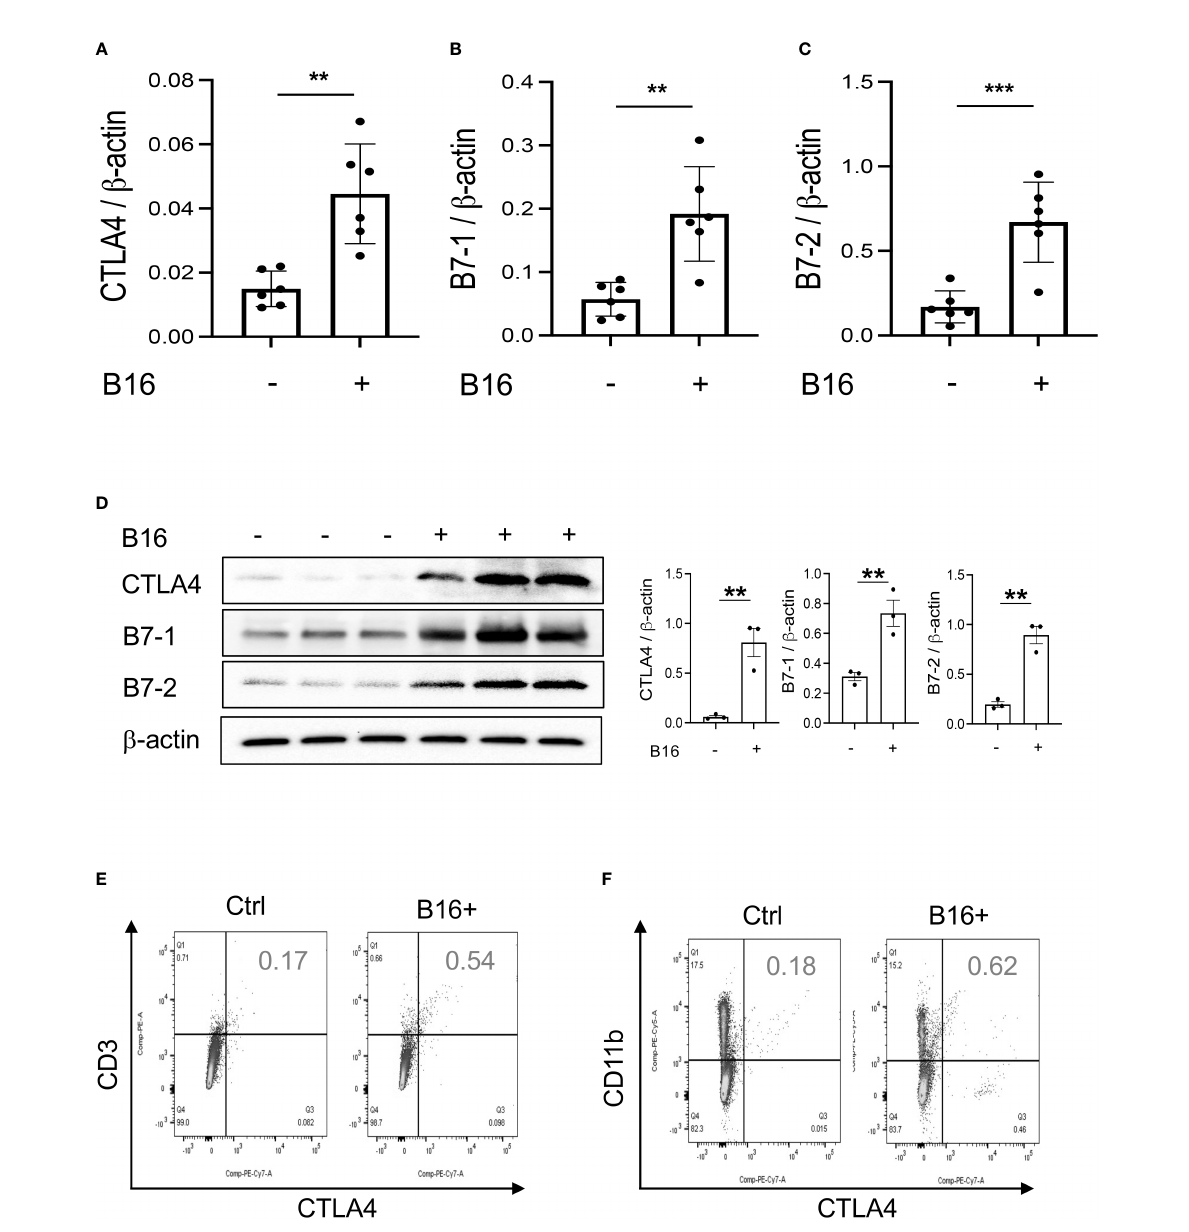
FIGURE 2 Chi3l1 plays a critical role in B16 melanoma stimulation of pulmonary CTLA-4 and its ligands. WT mice were given B16-F10 (B16) melanoma cells or control vehicle (PBS) and evaluated 2 weeks later. (A – C) RT-PCR was used to quantitate the levels of mRNA encoding CTLA-4, B7-1 and B72 in the lungs from mice treated intravenously with PBS vehicle (B16 -) or B16 cells (B16 +). Each dot represents an evaluation in an individual animal. (D) Western blot and densitometry evaluations of CTLA-4, B7-1 and B7-2 accumulation in lungs from WT mice treated with vehicle (B16-) or B16 cells (B16 +). (E, F) FACS analysis demonstrating the induction of CTLA-4 by CD11b+ and CD3+ cells. The plotted values in panels (A – C) represent the mean±SEM of the noted evaluations represented by the individual dots. Panels (D, E) are representative of a minimum of 2 similar evaluations. ** P < 0.01, *** P < 0.001 ( t-